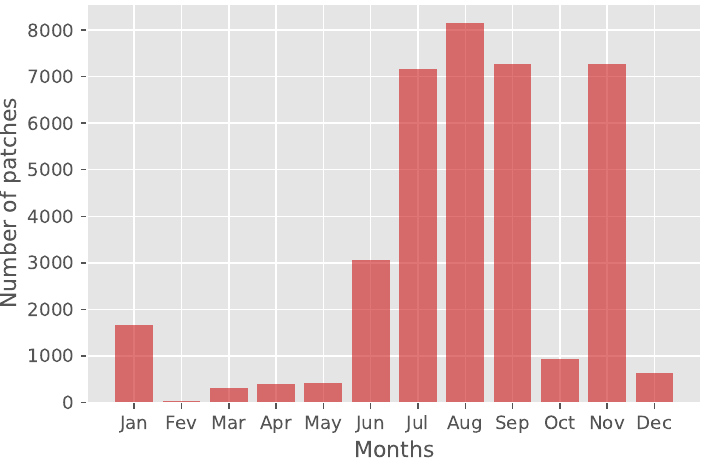
Figure 2. Number of patches with at least one Sentinel-2 image associated per